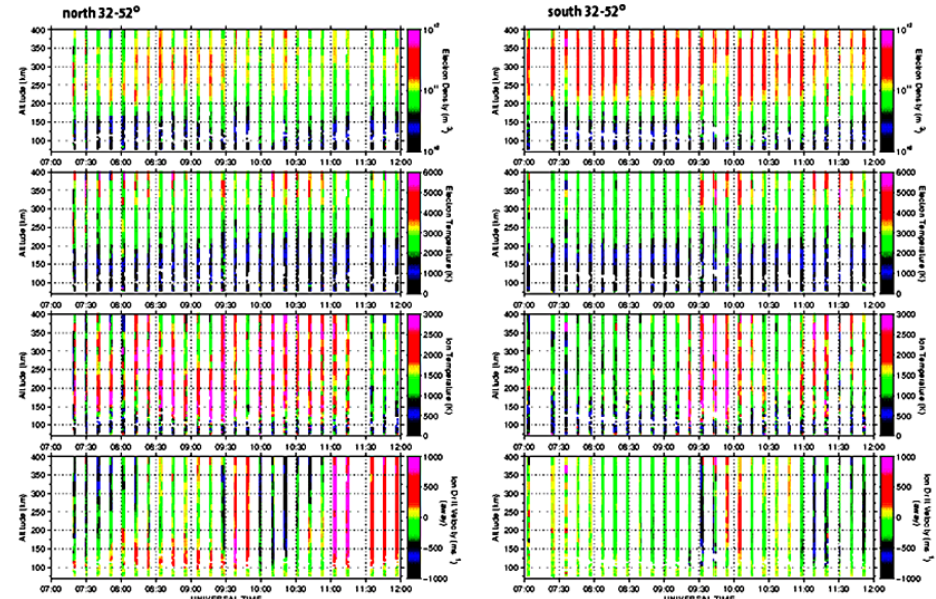
Figure 9. ESR observations with the 32m antenna on 12 March. The left panel indicates ionospheric data obtained from the northward- directed beams with elevation angles 32–52 ◦ . The right panel is the same as the left one except for southward-directed beams. Note that the ion drift direction away from the observation site is positive; namely, the poleward ion motion is positive and negative in the left and right panels, respectively.